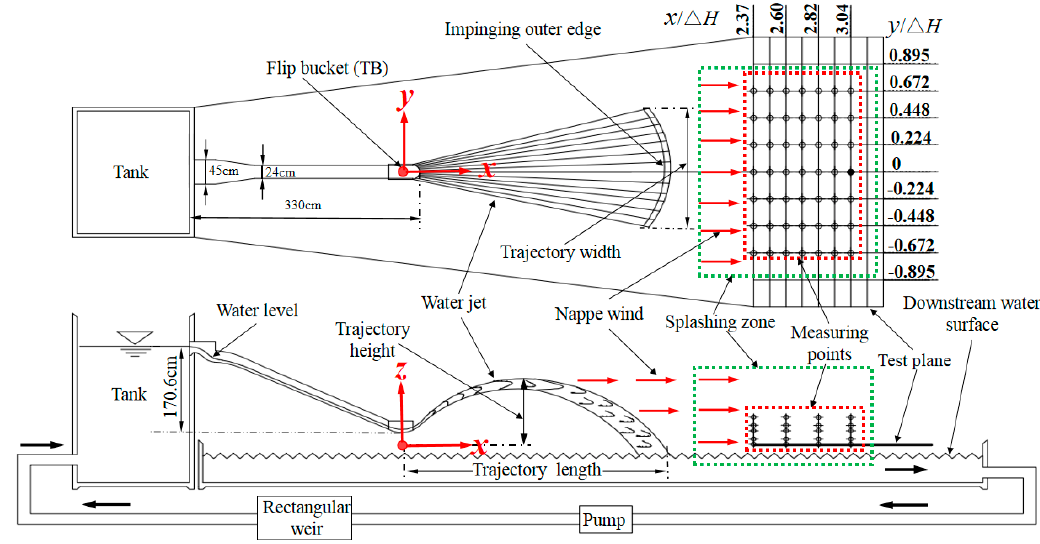
Figure 2. Schematic diagram of the experiments and measuring point arrangement as an example of a tongue-shaped bucket (TB).